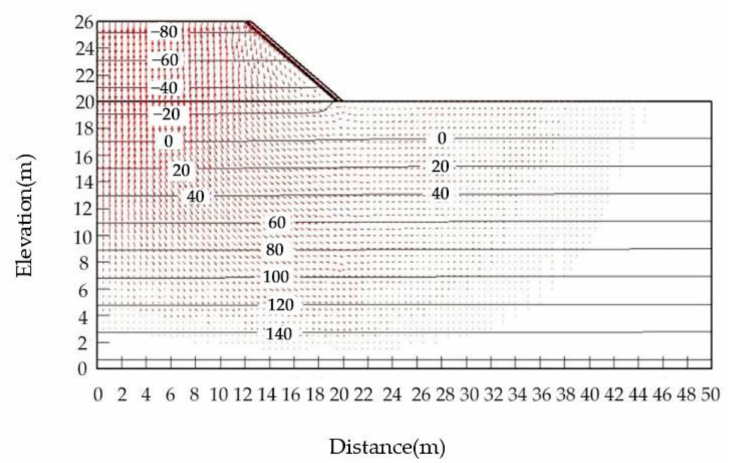
Figure 8. Deformation vector arrows of the subgrade with a capillary barrier.